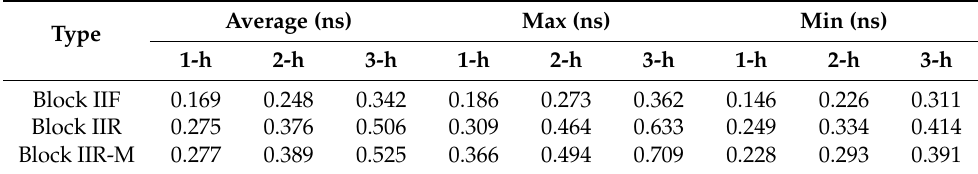
Table 5. The root mean square (RMS) of 1-h, 2-h, and 3-h prediction using the improved model and 3-h